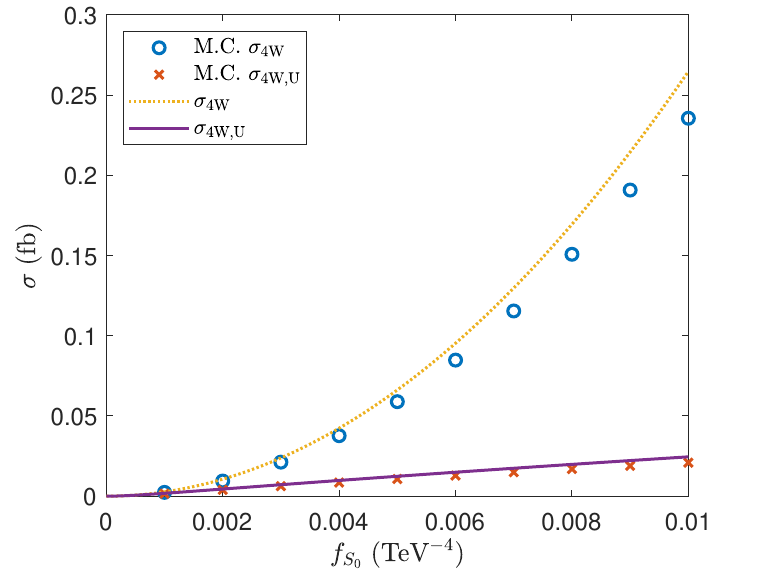
Figure 8 . σ 4W ( µ + µ − → ¯ ννW + W − → ¯ νν ¯ νν‘ + ‘ − ) compared with σ 4W , U ( µ + µ − → ¯ ννW + W − → ¯ νν ¯ νν‘ + ‘ − ) in eq. (A.6). This is only for an illustration that the unitarity bounds are necessary.